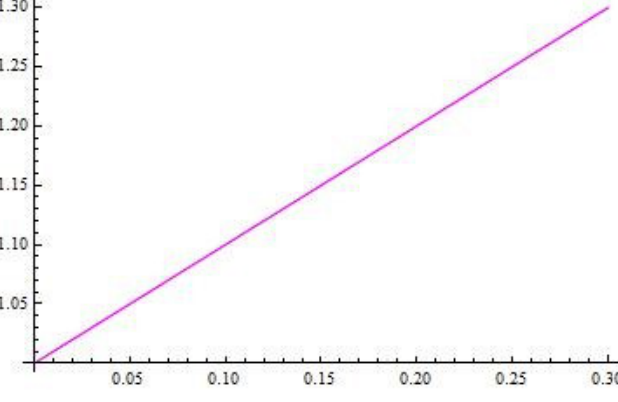
Fig. 8 Graph of the solution using AIM for the interval [ 0 , 0 . 3 )